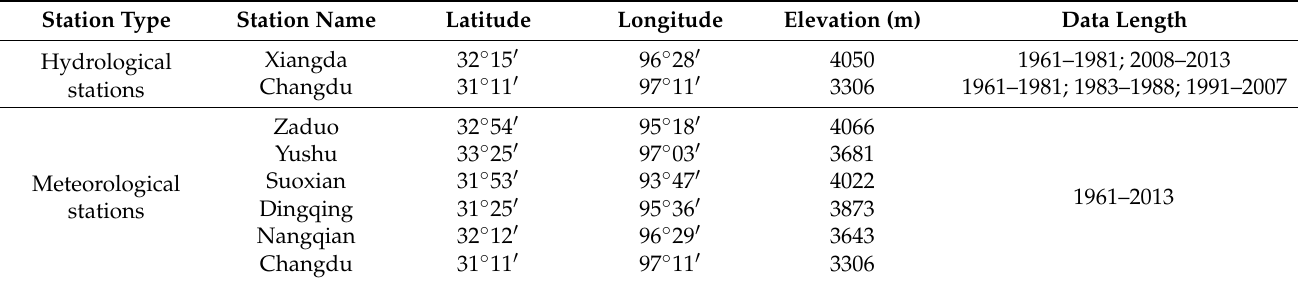
Table 1. Summary of hydrological and meteorological stations.